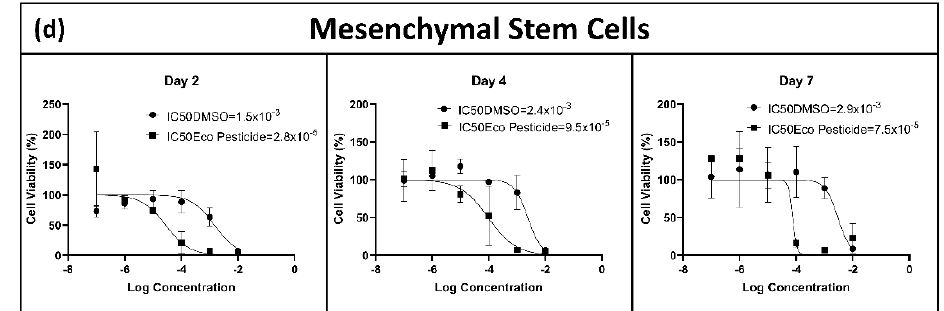
Figure 1. Cell cytotoxicity assessment and dose-response curve. ( a ) Assessment of cell viability in HEK-293 cell line (normalized data). The Eco-product shows a proliferative effect at the range of 10 − 3 dilution to 10 − 6 dilution (incubation period 2, 4, and 7 days) and a non-toxic profile. ( b ) Assessment of cell viability in a hu-MSCs cell line (normalized data). The Eco-product shows reduced cell viability between dilution range 10 − 2 –10 − 5 and a rescued proliferative effect at the range of 10 − 6 –10 − 7 dilution (incubation period 2, 4, and 7 days). Results are expressed as mean ± standard deviation (SD), and statistical significance was considered when p < 0.05. ( c ) Dose-response curve of HEK-293 treated with EP for 2, 4, and 7 days. The concentrations range between 10 − 3 and 10 − 6 , and ( d ) Dose-response curve of hu-MSC cells with concentrations ranging between 10 − 2 and 10 − 7 . Results are expressed in percentage of control, and they show the mean of IC50 values ± SD (concentration required to inhibit cell growth by 50%). Data represent the means of two independent experiments, with each concentration tested in triplicate.